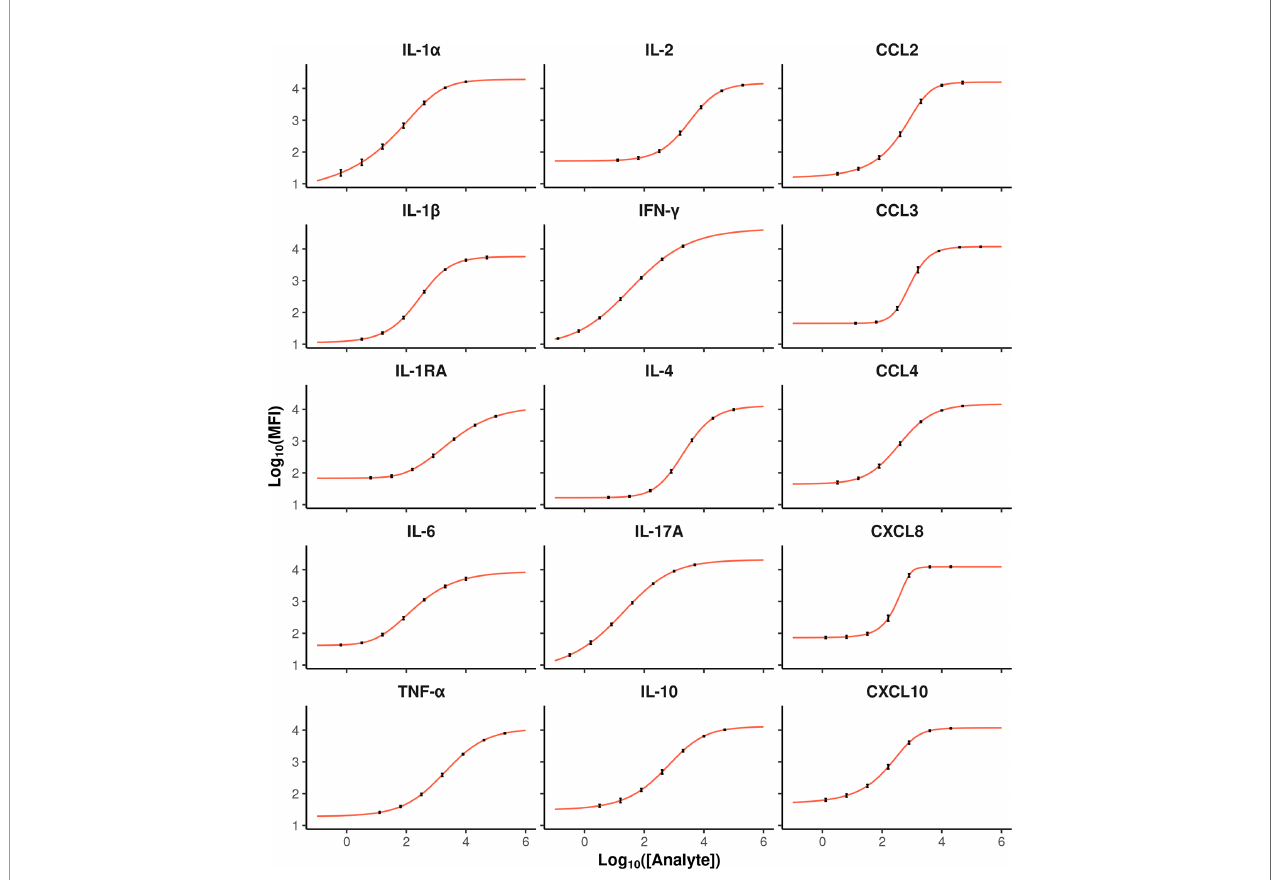
FIGURE 1 | Average dose – response curves for each cytokine (red curves). The x and y-axis represent analyte concentration and the Log10 MFI value, respectively. Each dot corresponds to the average response of a given standard, and the error bars show the variances calculated on values from 6 plates for each cytokine.